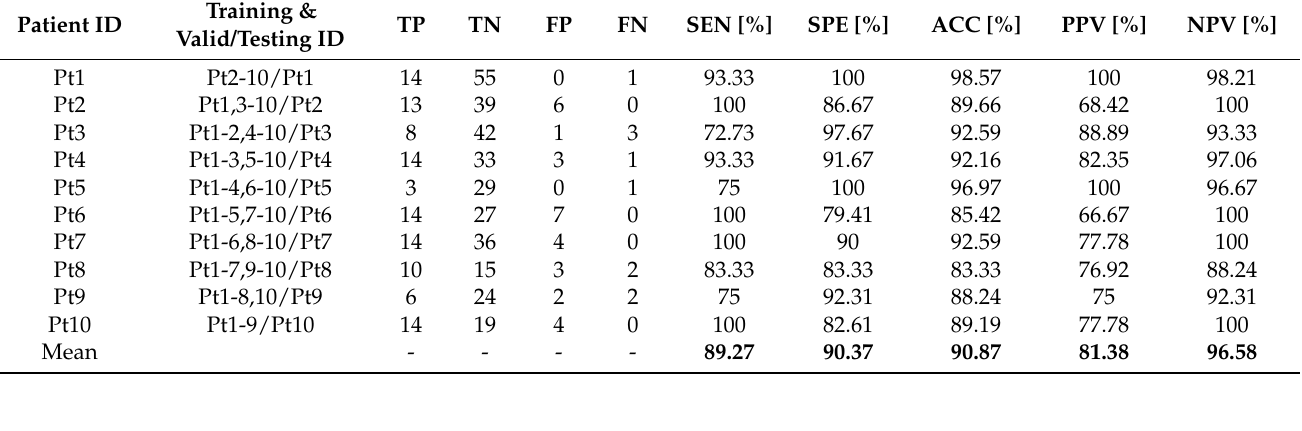
Table 5. Individual patient experimental results using the proposed method MEBM-SC.